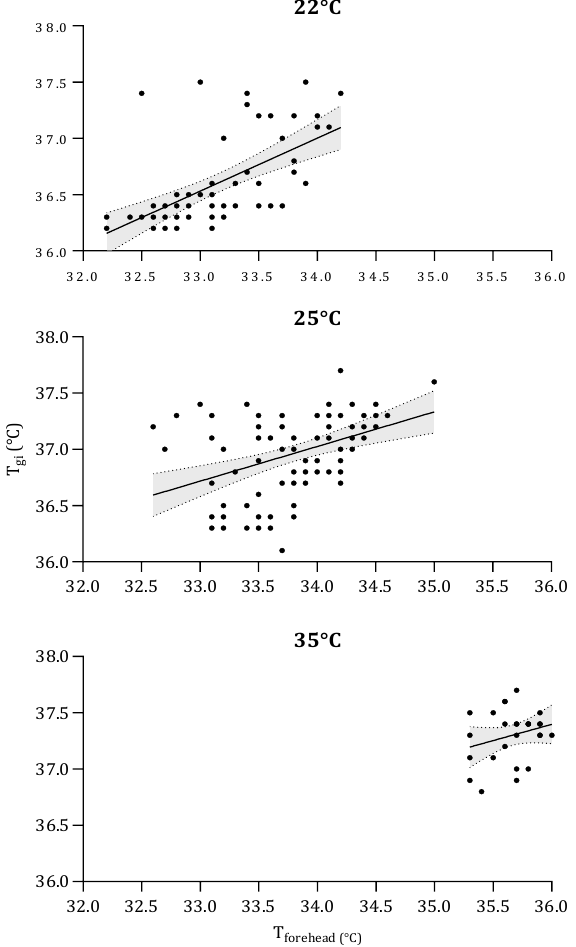
Figure 1. The relation between the temperature of the gastrointestinal tract measured with a radio pill (T gi ) and the temperature of the forehead using a contact thermistor (T forehead ). Measurements were obtained while participants were exposed to three ambient temperatures: 22 ◦ C (upper panel), 25 ◦ C (middle panel), and 35 ◦ C (lower panel). Regression lines with associated 95% confidence bands for each temperature are also shown.